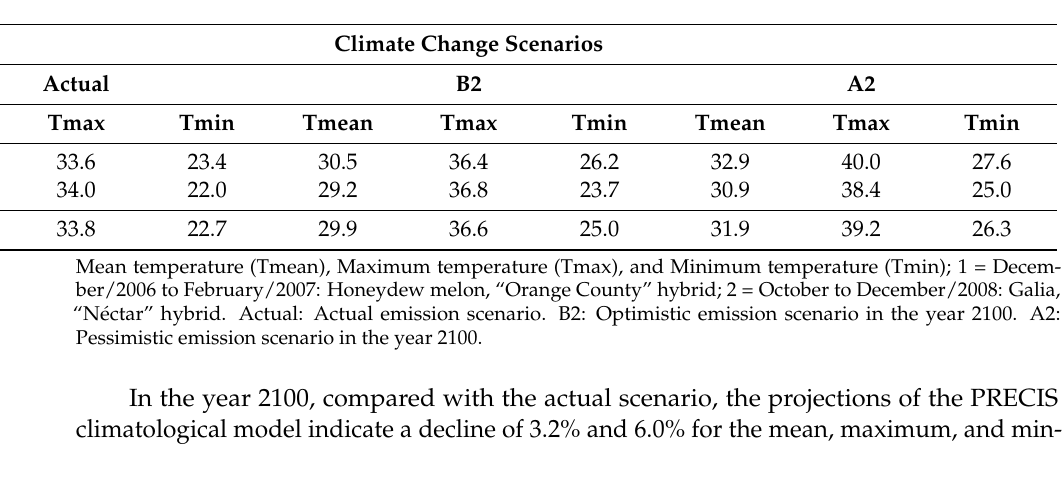
Table 1. Air temperature values ( ◦ C) in Mossor ó , Rio Grande do Norte state, Brazil, during the melon cultivation period (cultivars Honeydew and Galia), using the PRECIS climatological model, and considering the Intergovernmental Panel on Climate Change’s emission